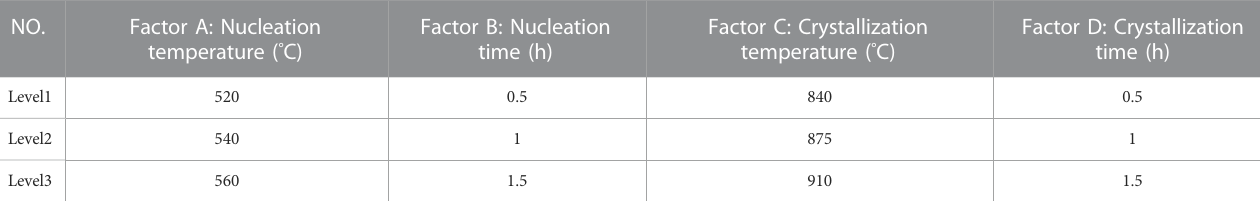
TABLE 2 Orthogonal test table.